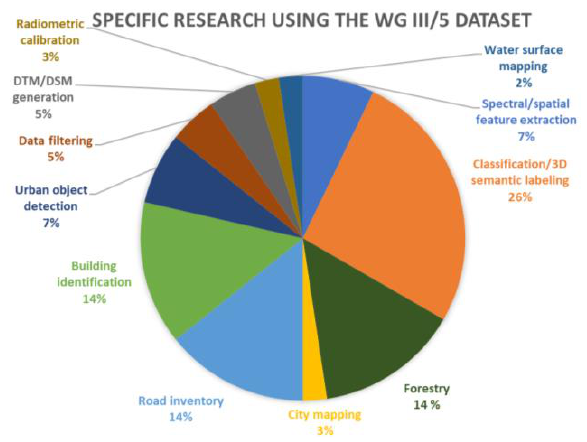
Figure 7 . Specific research topic investigated on the basis of the ISPRS WG III/5 Data